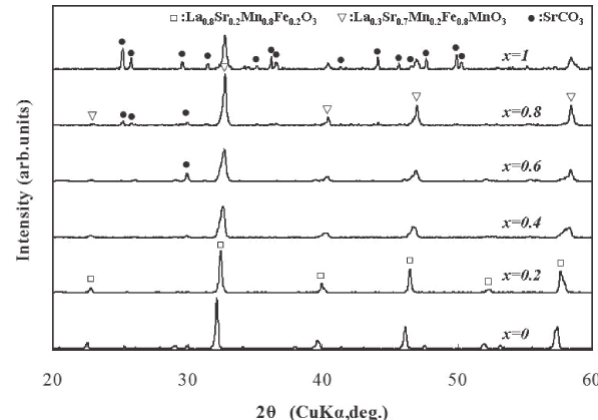
Sr Mn Fe O 1 − x x 0.4 0.6 3